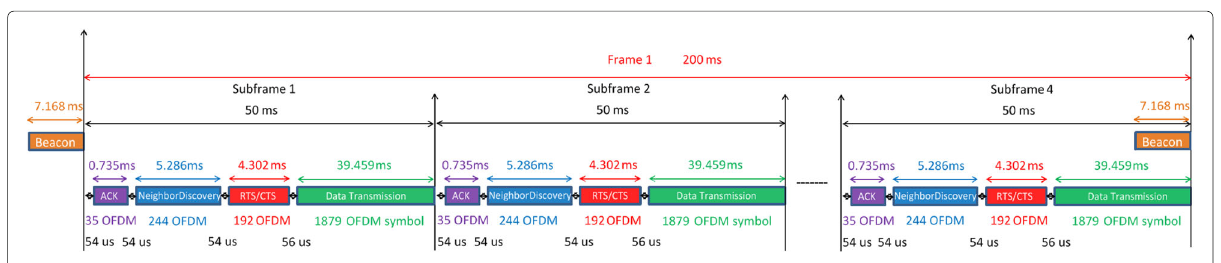
Fig. 2 Frame structure of the proposed